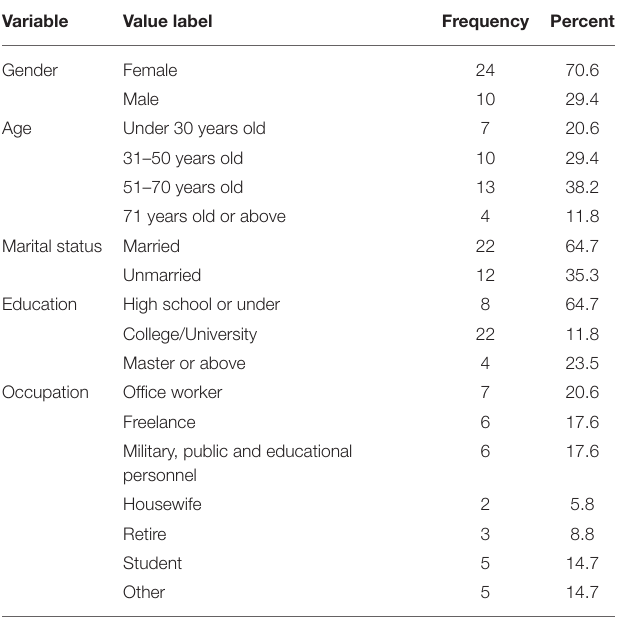
TABLE 2 | Summary table of descriptive statistics.